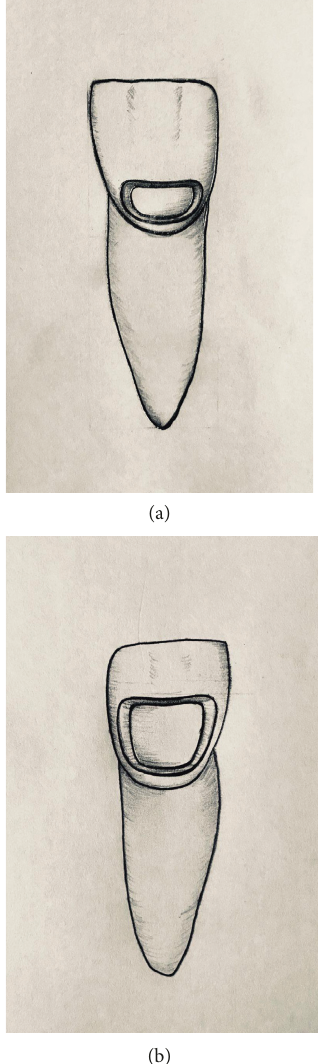
Figure 1: (a) Representative of a small class V cavity (b) and large class V